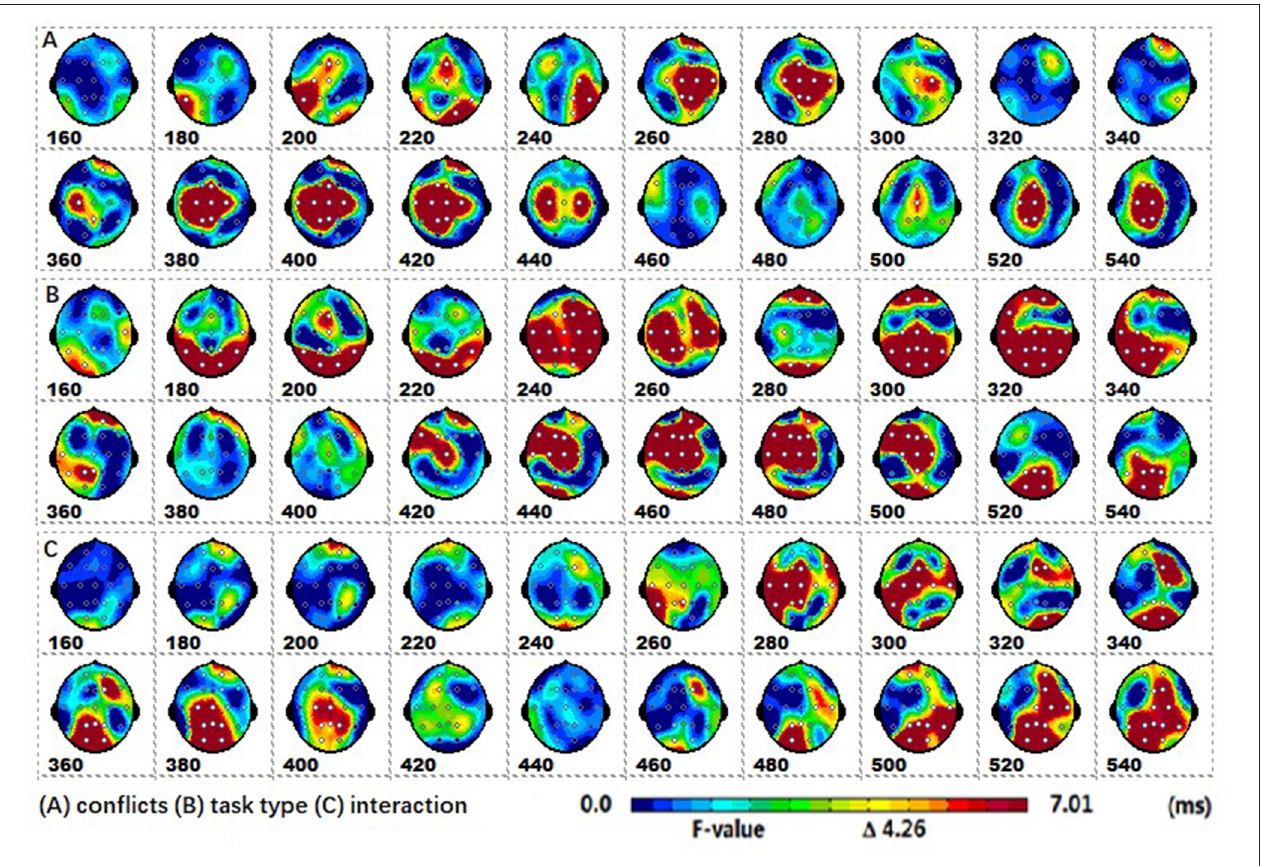
FIGURE 3 | The spatiotemporal patterns of SPM ( F ) (160 to 540ms) are derived from the two-way (conflict: congruent vs. incongruent, and stimulus type: arrow flanker vs. color flanker) repeated measures ANOVA: (A) the conflict effect, (B) the task type effect, and (C) the interaction effect. Each map was interpolated from the average F -values within the fixed 20-ms time window, and the bright yellow bin of the color scale corresponded to the.05 significance threshold: F (1,24) = 4.26. The white dots represented the electrode sites with significant